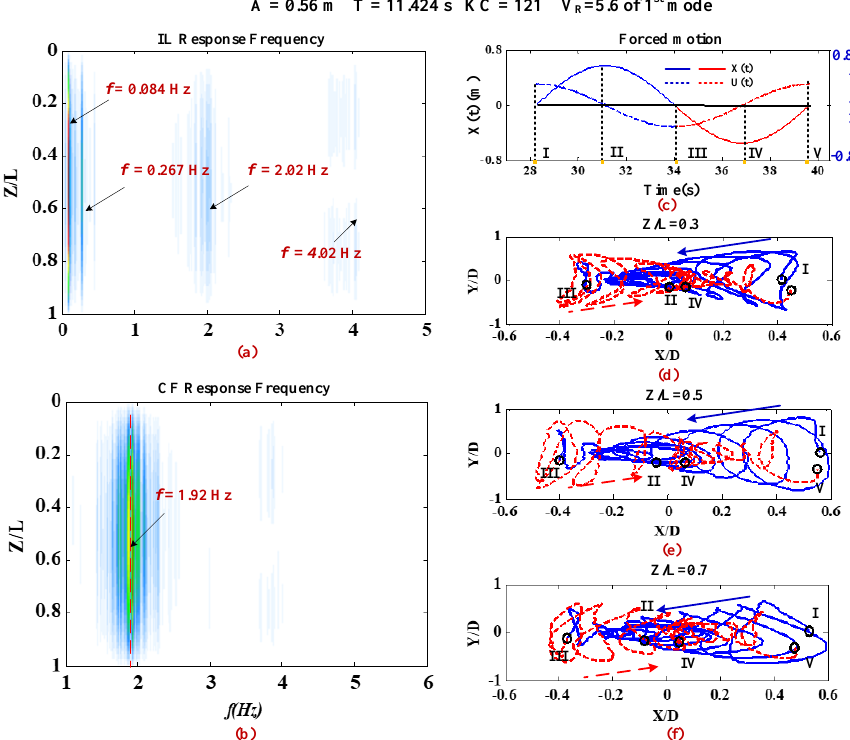
Figure 17. The spatial distribution of response frequency and displacement trajectories at different positions when KC = 121 and V R1 = 5.6.